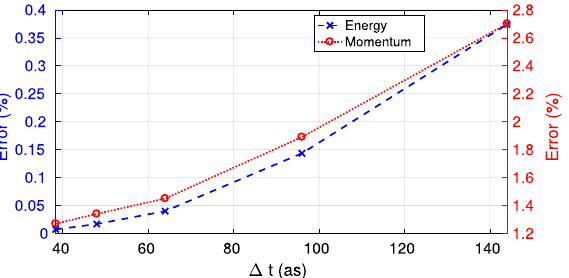
Figure 5. Numerical errors induced by the PSATD/Hydro code on conservation of energy (blue curve) and momentum (red curve). The errors were calculated from simulations of S-polarized electromagnetic wave over a plasma ramp, with different time step (cid:31) t . All other parameters are identical to those of Fig.